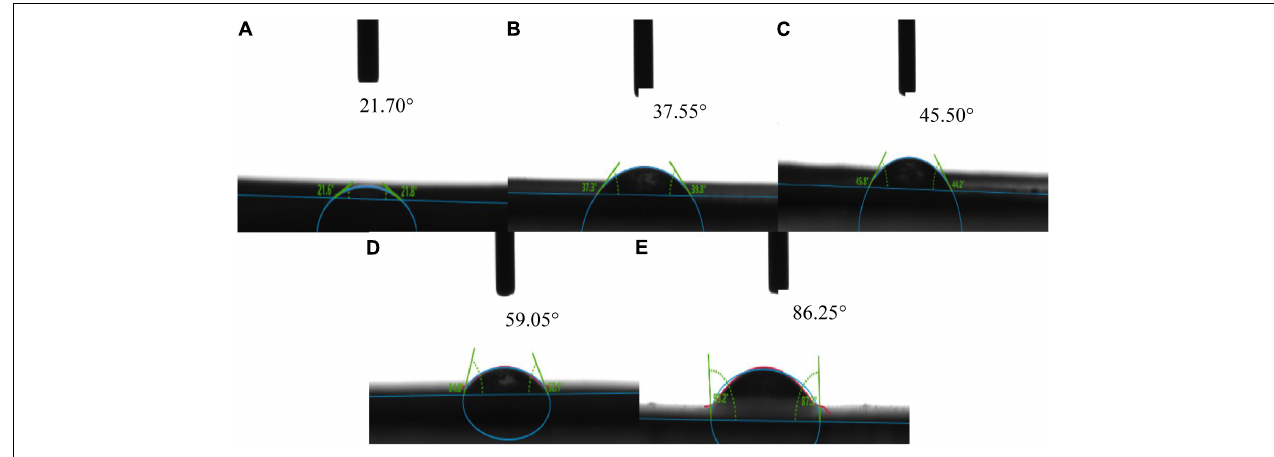
FIGURE 3 | The water contact angle of corn starch-based films supplemented with GLY and ERY (A) (0:4), (B) (1:3), (C) (2:1), (D) (3:1), and (E) (4:0).